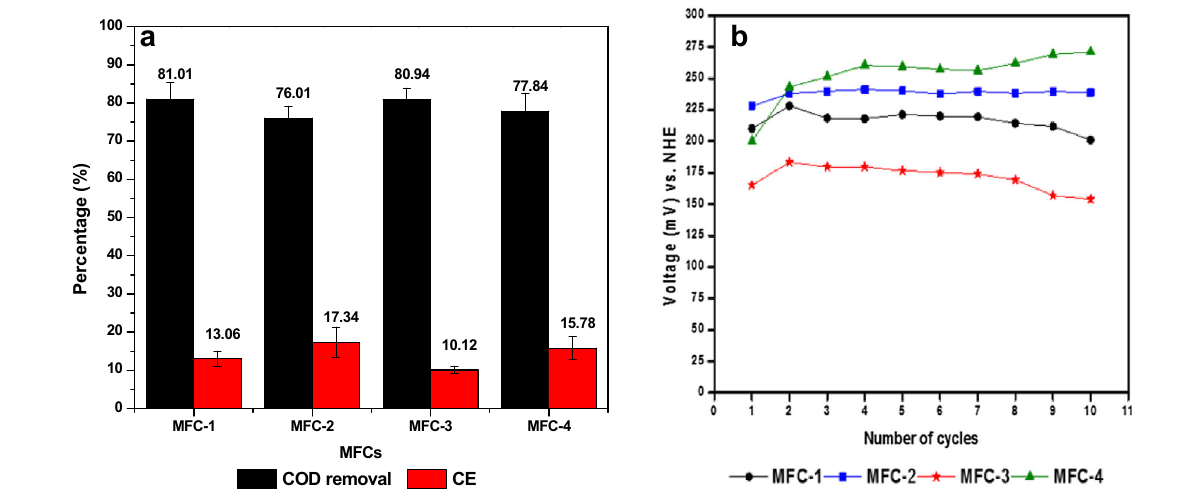
Fig. 2 a COD removal and CE of MFCs, b Operating Voltage of the MFCs